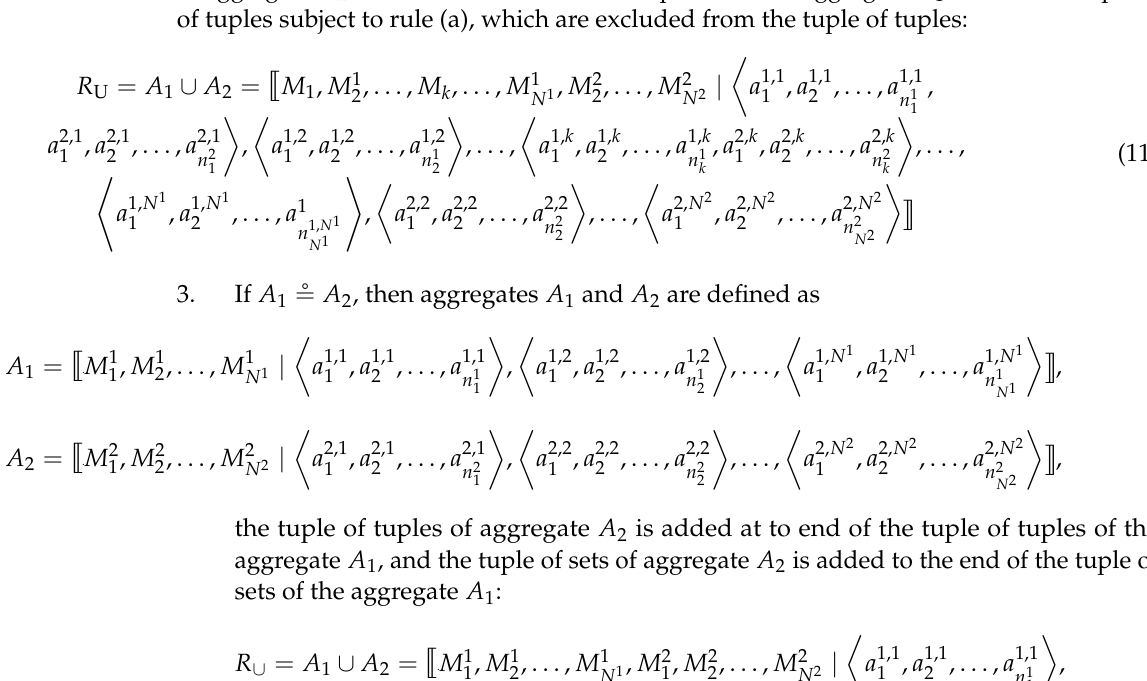
Figure 4. An example of two hiddenly compatible aggregates. Figure 1. An example of two compatible aggregates. Figure 2. An example of two quasi-compatible aggregates.